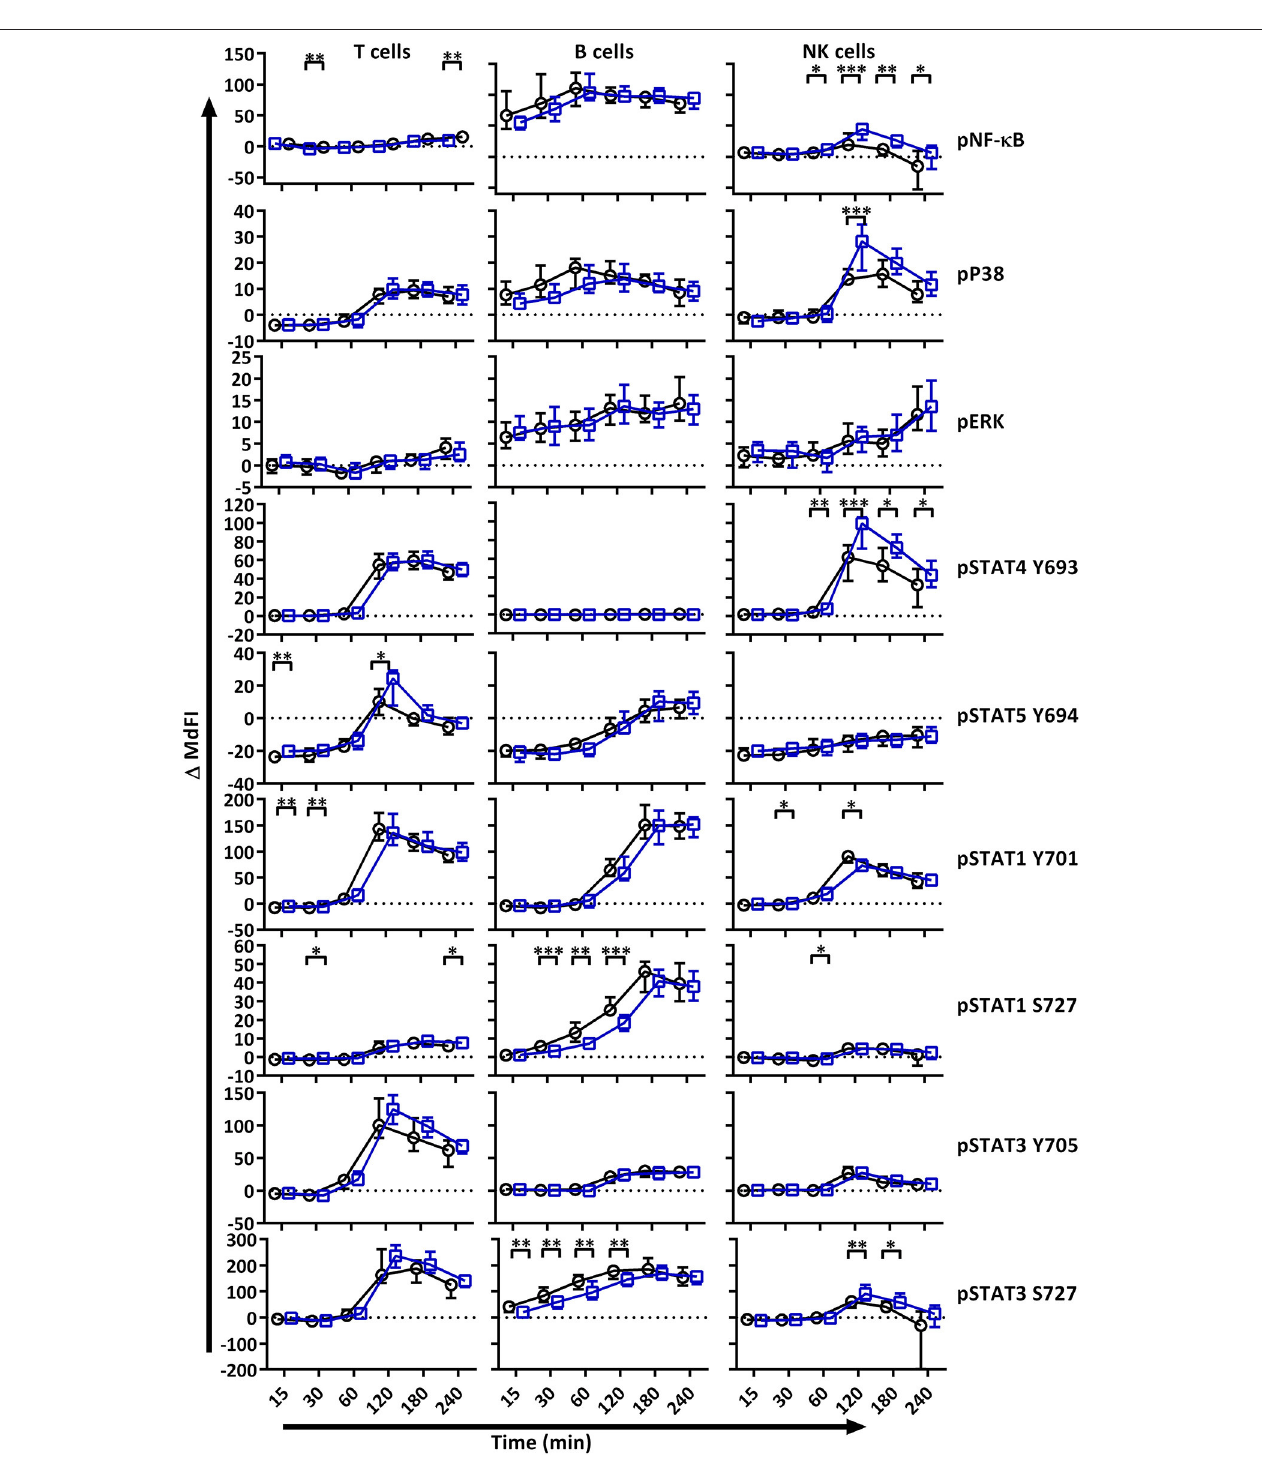
FIGURE 2 | TLR stimulation results in different phosphorylation profiles in B cells, T cells, and NK cells of pSS patients compared to healthy controls. Phosphorylation levels of NF- κ B, P38, ERK1/2, STAT4 Y693, STAT5 Y694, STAT1 Y701, STAT1 S727, STAT3 Y705, and STAT3 S727 were analyzed by flow cytometry at different time points after stimulation with TLR7 and − 9 ligands. Comparisons of change of phosphorylation levels ( 1 MdFI) between pSS patient (black) and healthy donors (blue) are given. Comparisons between pairs were done using an Unpaired Mann-Whitney test. Line graphs show the median and 25–75 percentiles. Differences were considered statistically significant when p ≤ 0.05, with significance indicated as * ≤ 0.05, ** ≤ 0.01, *** ≤ 0.001 and **** ≤ 0.0001. The data represents 25 healthy controls and 25 patients pooled from 13 independent experiments.